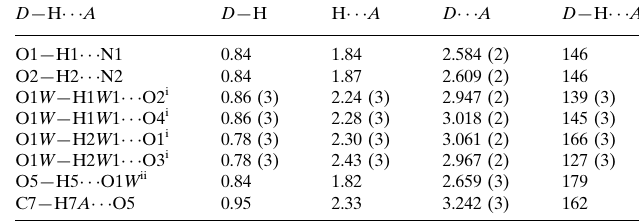
Data collection Bruker SMART APEXII CCD area-detector diffractometer Absorption correction: multi-scan ( SADABS ; Bruker, 2005) T min = 0.961, T max = 0.999